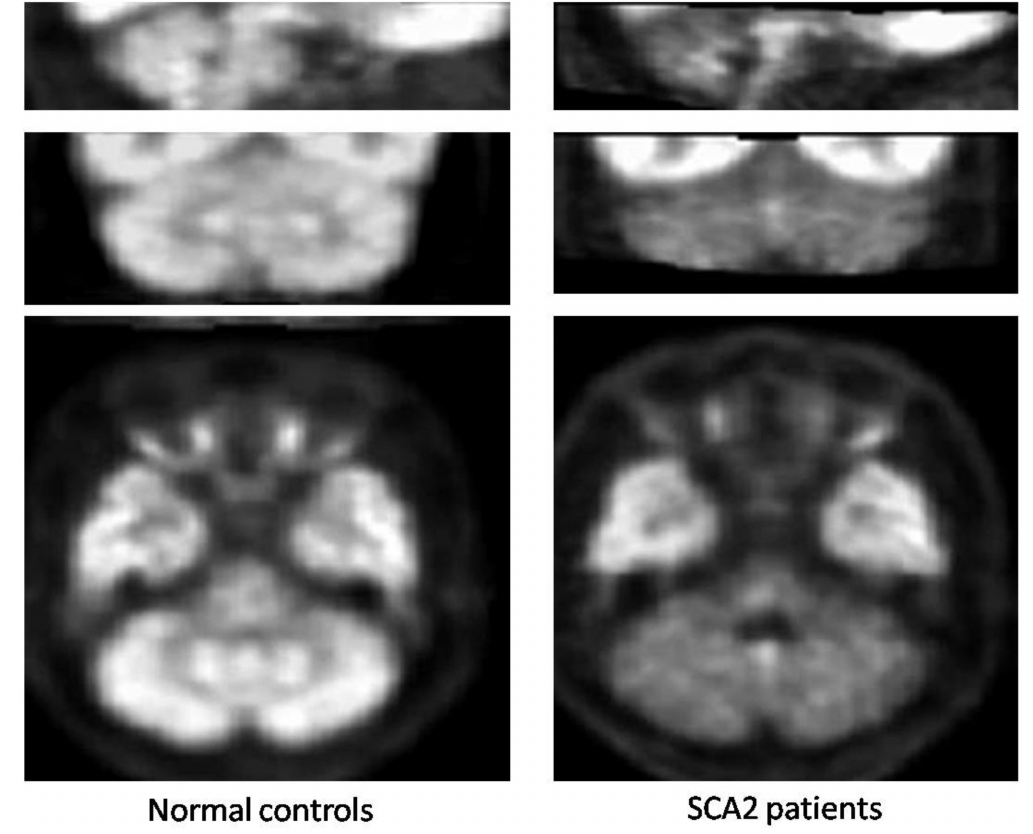
Figure 7. 18F-fluorodeoxyglucose positron emission tomography in SCA2.Representative sagittal (top), coronal (mid) and axial (bottom) images of spatially normalized ratios of cerebellar to cerebral 18F-fluorodeoxyglucose uptake using study-specific templates in 89 normal controls (left panels) and 9 patients with SCA2 (right panels) show di ff usely decreased hypometabolism in the cerebellar cortex and dentate nuclei (mid and bottom images). Note in the SCA2 patients, the decreased tracer uptake in the basis pontis and medulla oblongata as well (top and bottom images). Modified from Oh M, Kim JS, Oh JS, Lee CS, Chung SJ: Di ff erent subregional metabolism patterns in patients with cerebellar ataxia by 18F-fluorodeoxyglucose positron emission tomography. PLoS One 12: e0173275,